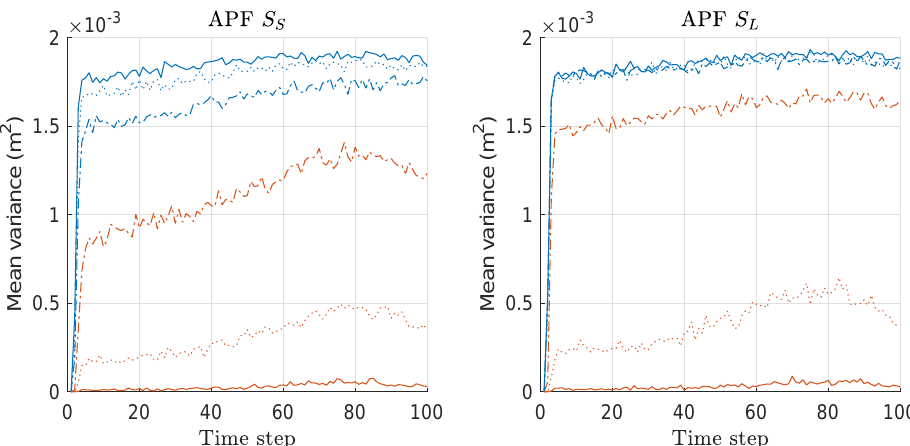
Figure 6. Mean-variance of the weights of particles over 300 runs with 1000 particles for APF and MAPF. These results are associated with the results of mean square error of distance (MSED) and mean-risk of Figures 4 and 5. Legend: line style (dash-dot: M = 2; dotted: M = 5; solid: M = 10); (line color: blue: APF; red: MAPF).